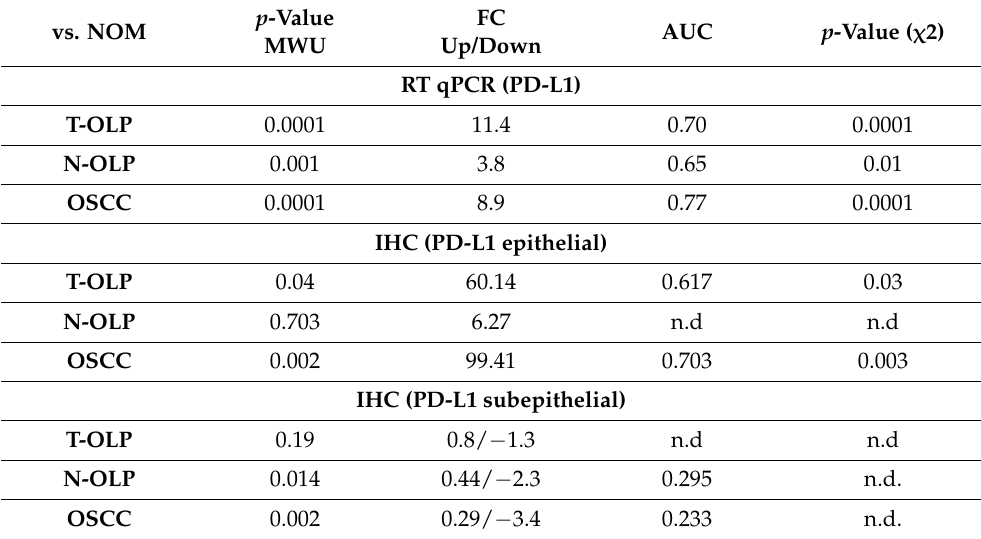
Figure 4. Comparison of the expression rates of PD-L1 in the epithelium and the subepithelium of T-OLP and N-OLP. Comparison of the protein expression rates of PD-L1 in the epithelium ( A ) and the subepithelium ( B ) of T-OLP and N-OLP PD-L1 was significantly overexpressed in epithelial compartment. ( C ) RT qPCR expression analysis in all tissue samples of the groups provide no significant difference in the expression level in T-OLP compared to N-OLP. ( D ) ROC, AUC value confirms the significant association between epithelial protein overexpression and malignant trans-formation (T-OLP (positive status) vs. N-OLP). ( E ) Malignant transformation is significantly associated with epithelial overexpression of PD-L1 protein ( χ 2-test). o stands for an outlier; * indicates an extreme value. Table 4. Comparison of the expression rate of PD-L1 and PD-1 between NOM and the OSCC, T- OLP and N-OLP group.